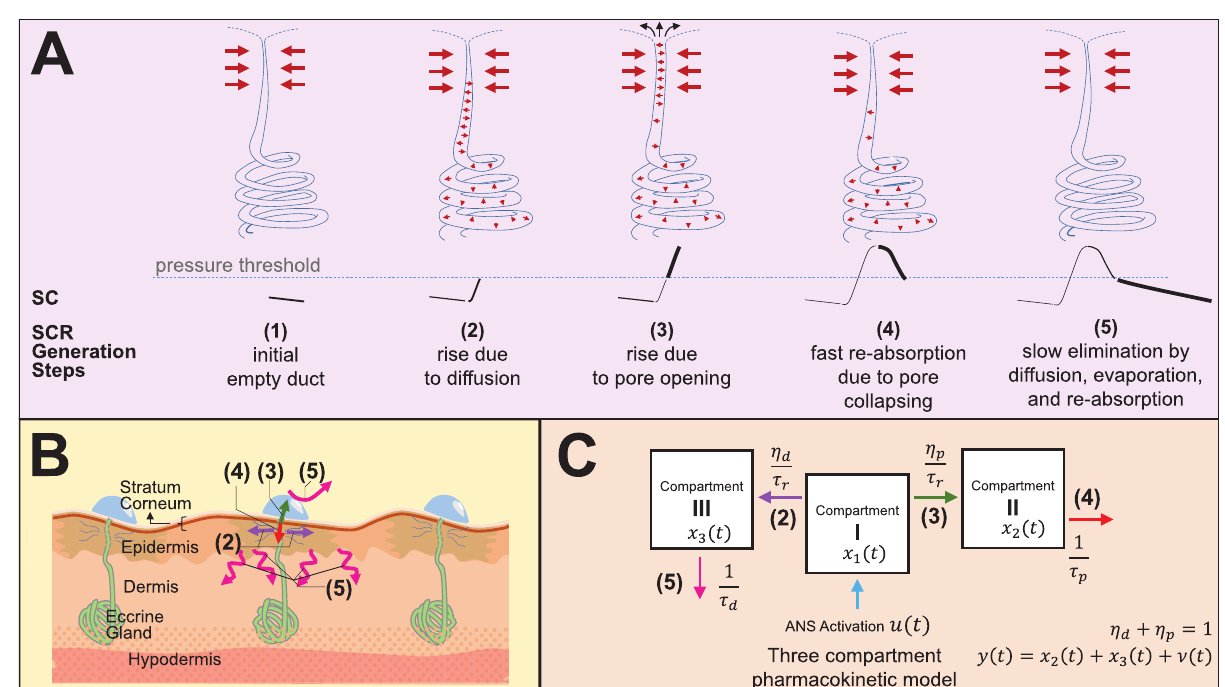
Fig 1. An overview of the physiology and corresponding proposed model. (A) A step by step illustration of the poral valve model proposed by Edelberg [33]. (B) An illustration of the cross section of the skin segment and corresponding different regions contributing to the SCR generation process based on poral valve model . (C) A three compartment pharmacokinetic realization of the poral valve model . The arrows with different colors in panel B and C correspond to the secretion and clearance of sweat contents in different steps denoted by the associated step numbers as represented in panel